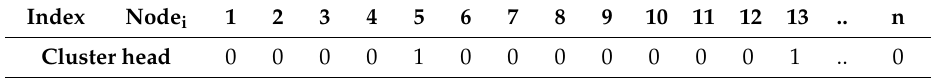
Table 6. The attribution of existing cluster heads (CHs) if flag = 1 and node is set to cluster head (CH). Otherwise node is set to member node